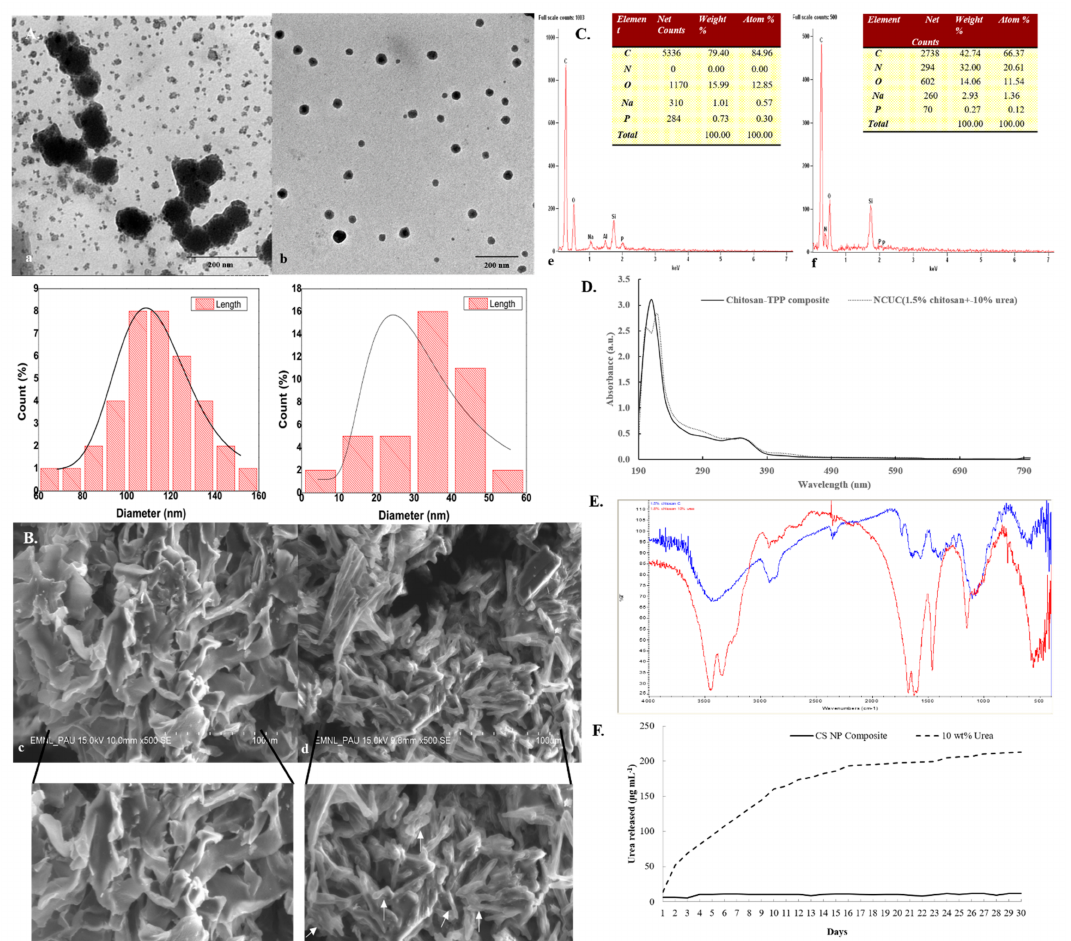
Figure 1. Characterization of chitosan and NCUC. Representative ( A ) TEM micrograph (15.0 K magnification, 80 kV acceleration voltage, high-contrast imaging mode), ( B ) SEM micrograph (500X magnification, 15.0 kV acceleration voltage, secondary electron imaging mode), ( C ) SEM-EDS spectra and elemental composition, ( D ) UV-Vis spectra, ( E ) FT-IR spectra and ( F ) release profile of NCUC. Solid white arrows represent the formation of layered structures in NCUC.